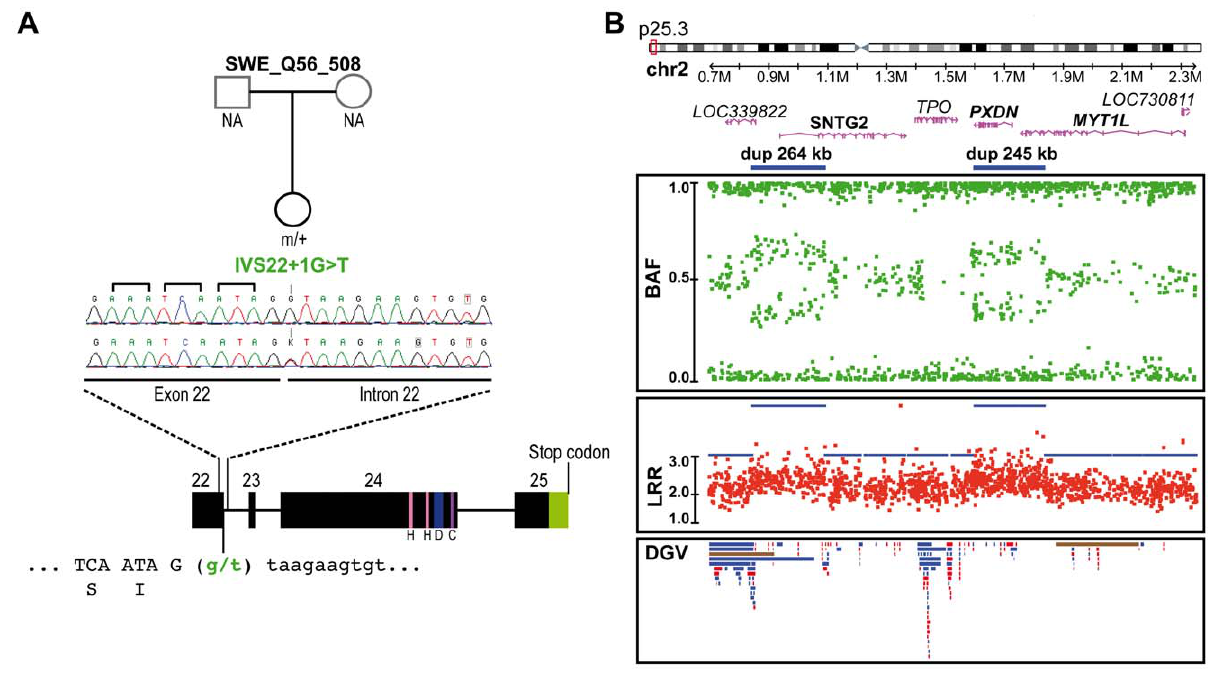
Figure 3. Genetic alterations identified in the control subject SWE_Q56_508. A. SHANK2 splice mutation (IVS22 + 1G . T) detected in a Swedish female control, SWE_Q56_508. The mutation altered the donor splicing site of exon 22 and led to a premature stop in all SHANK2 isoforms except for the AF1411901 isoform, where it altered the protein sequence (G263V). B. CNVs in the same individual altering LOC339822 , SNTG2 , PXDN and MYT1L . The two close duplications span 264 kb and 245 kb on chromosome 2 and altered LOC339822 and SNTG2 , and PXDN and MYT1L , respectively. Dots show the B allele frequency (BAF; in green), Log R ratio (LRR; in red), and QuantiSNP score (in blue). Lower panel: all CNVs listed in the Database of Genomic Variants (DGV) are represented: loss (in red), gain (in blue), gain or loss (in brown). H, homer binding site; D, dynamin binding site; C, cortactin binding site.